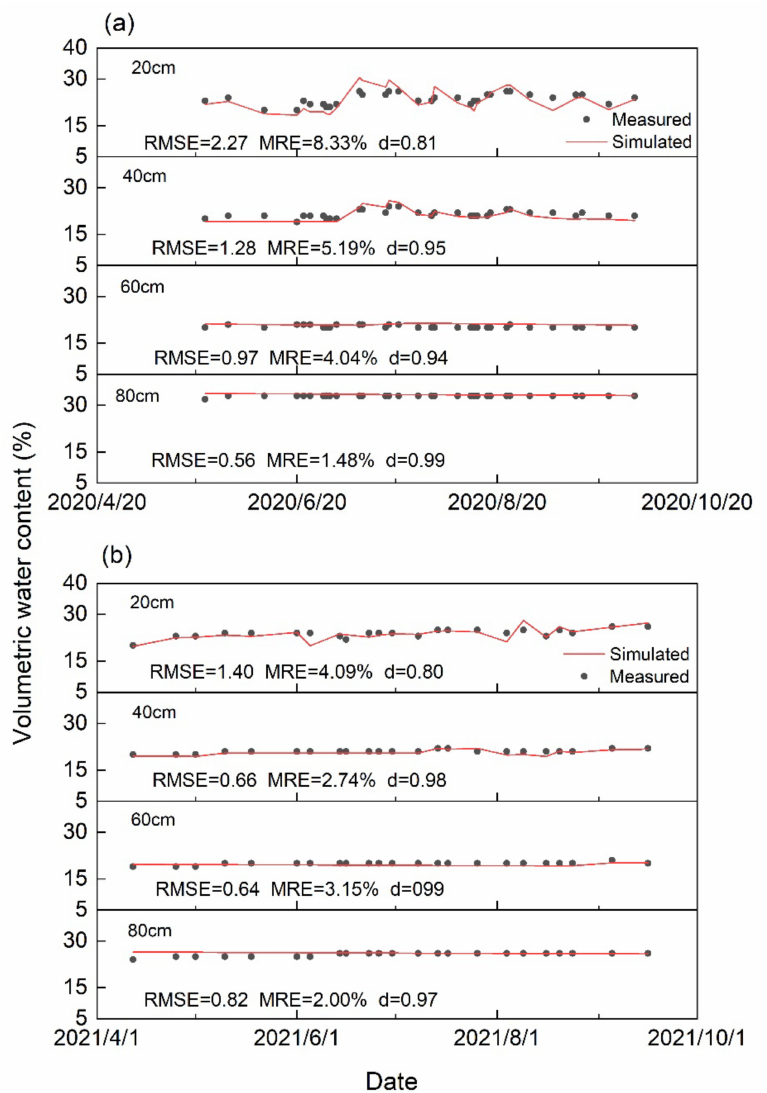
Figure 7. Comparison between measured volumetric water content (VWC) in the 20 cm, 40 cm, 60 cm and 80 cm profile the simulated values by RZWQM2 during the growth period of turf in 2020 ( a ) and 2021 ( b